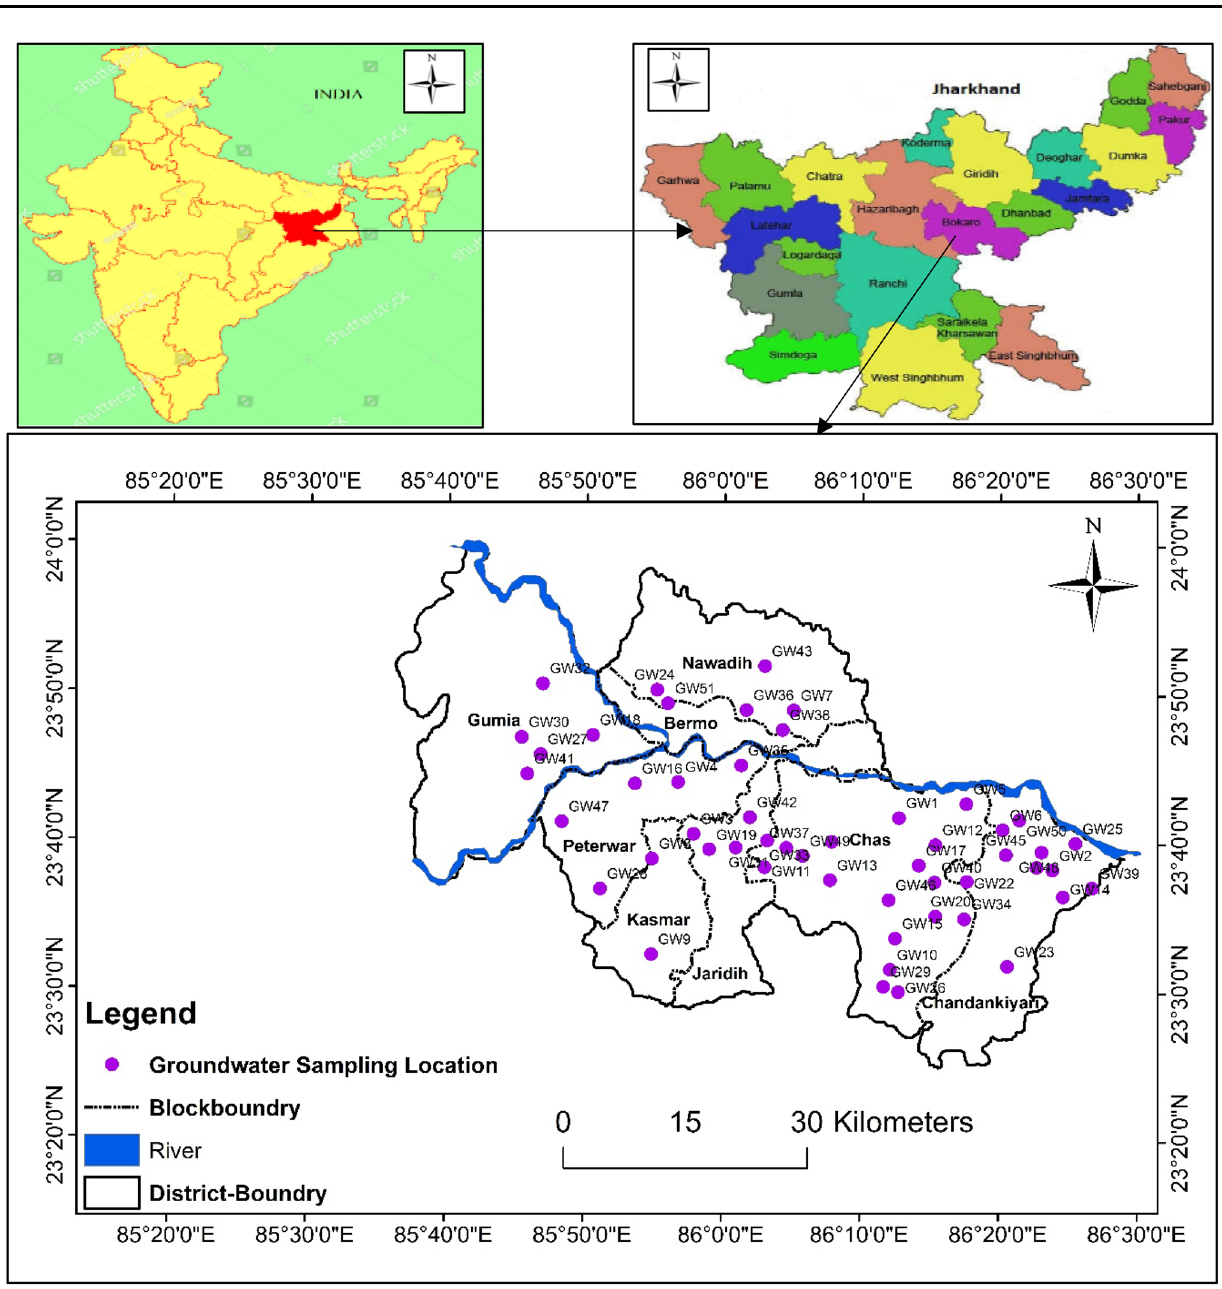
Fig. 1 Groundwater sample location in the Bokaro